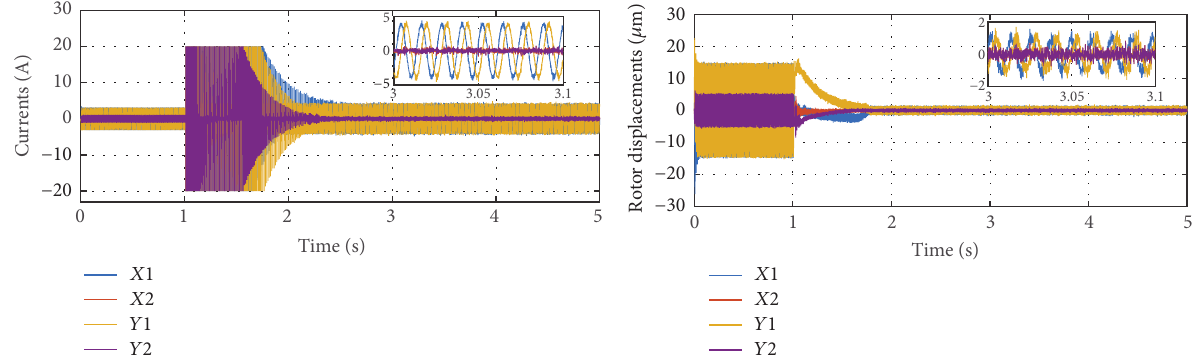
Figure 15: Control currents and rotor displacements in radial directions: saturation current is 20